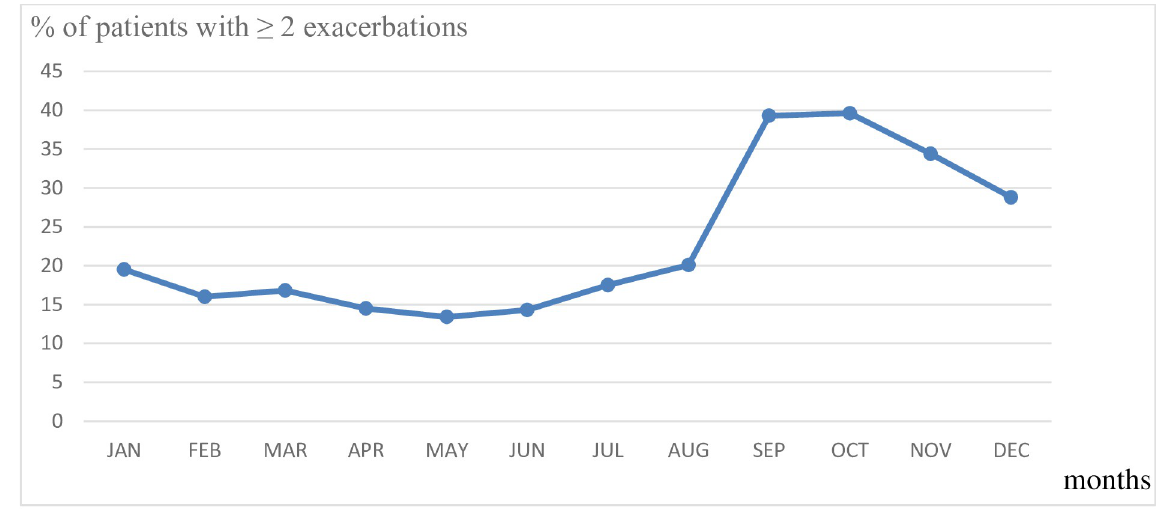
Fig 2. Frequency of AF flare-ups by